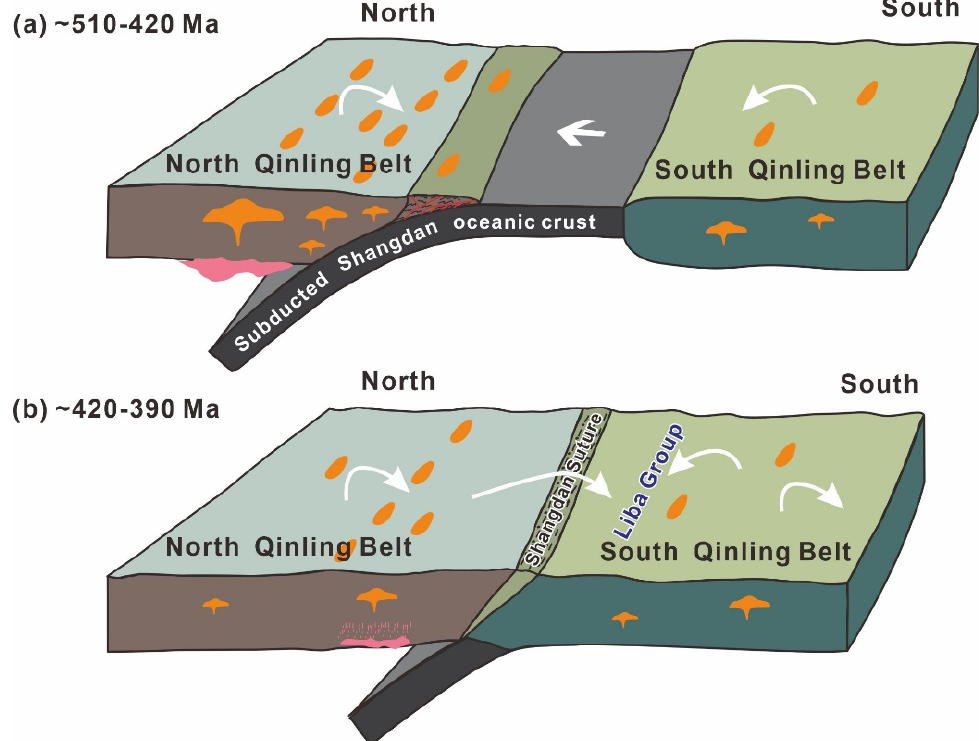
Figure 13. Schematic cartoon showing the tectonic evolution of the Shangdan Ocean. ( a ) Subduction of the Shangdan oceanic slab from 510 to 420 Ma. ( b ) Collision between the North Qinling Belt and South Qinling Belt at ca. 420 Ma. The white arrows show the transport direction of detrital sedi- ments.